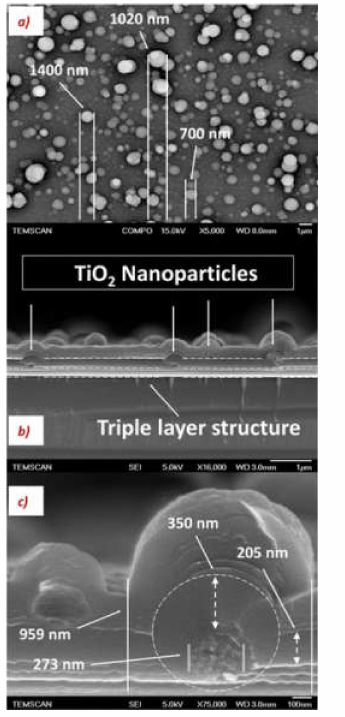
Figure 11. Scanning electron microscopy (SEM) images of the coating, showing heterostructures of TiO 2 nanoparticles embedded between thin silica layers. ( a ) Backscattered image of the top surface, ( b,c ) secondary electron images of a cross-section of the coating. Reprinted with permission from [61]. Copyright 2006 John Wiley & Sons, Inc.